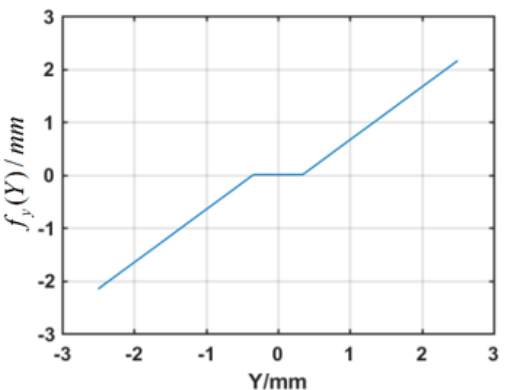
Figure 3. Lateral backlash function.